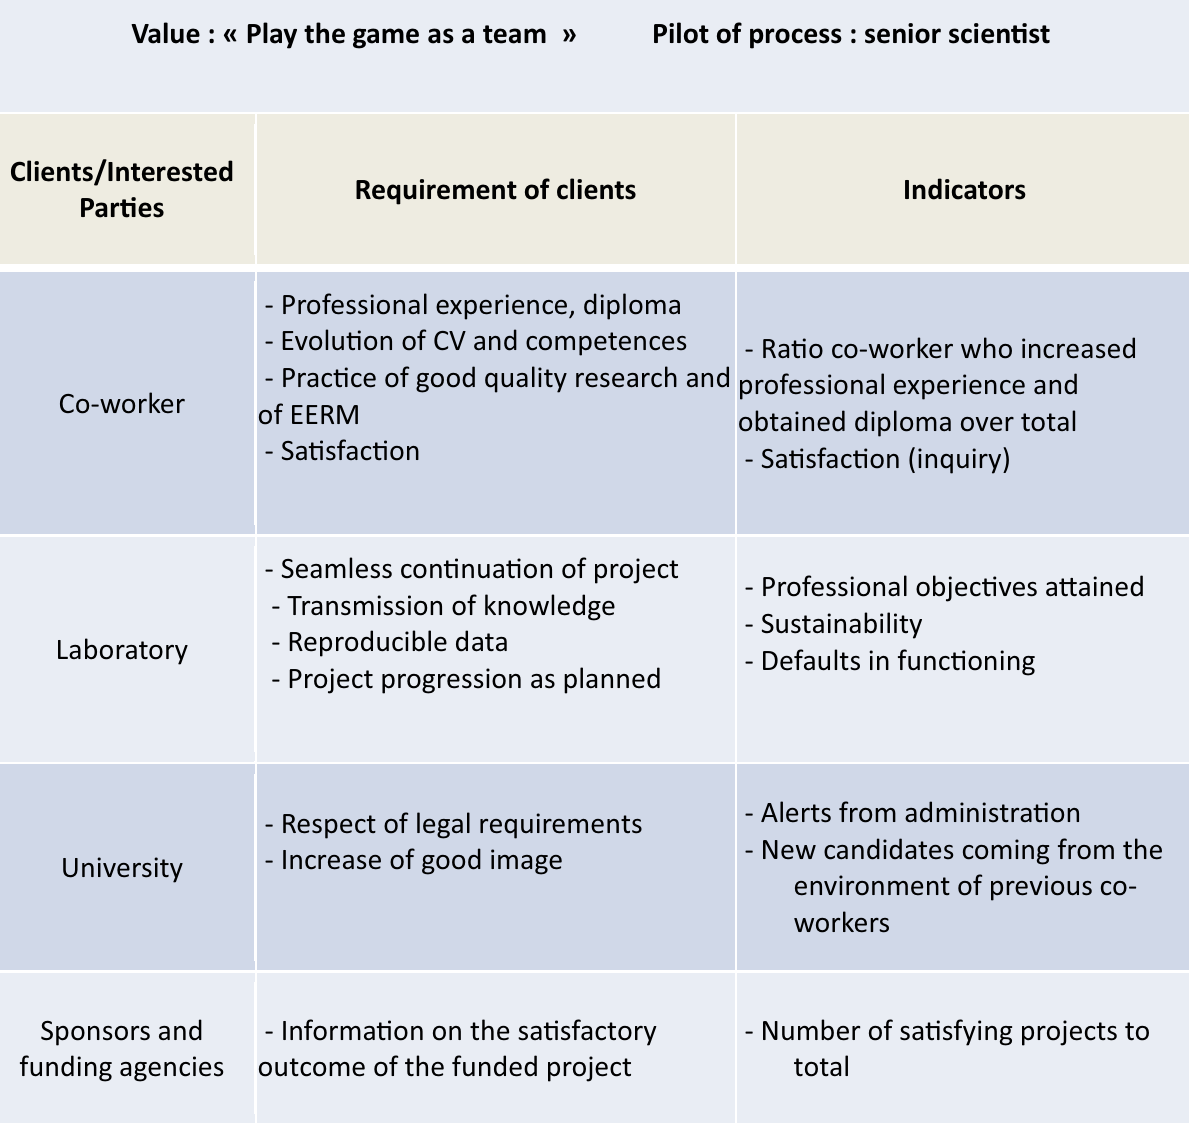
Fig. 1b. ID card of process “ Departure of a co-worker ”